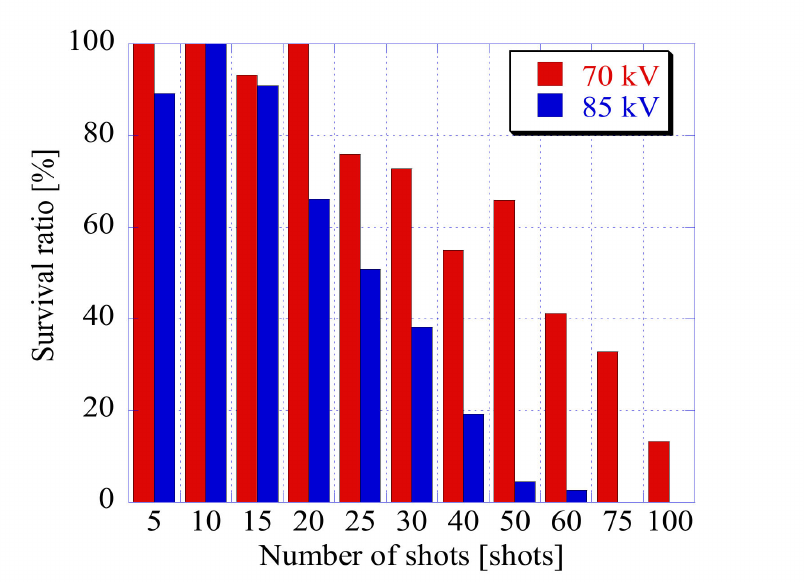
Figure 6. Survival ratios of E. coli on the surface of agar medium in configuration (1) by applying pulsed